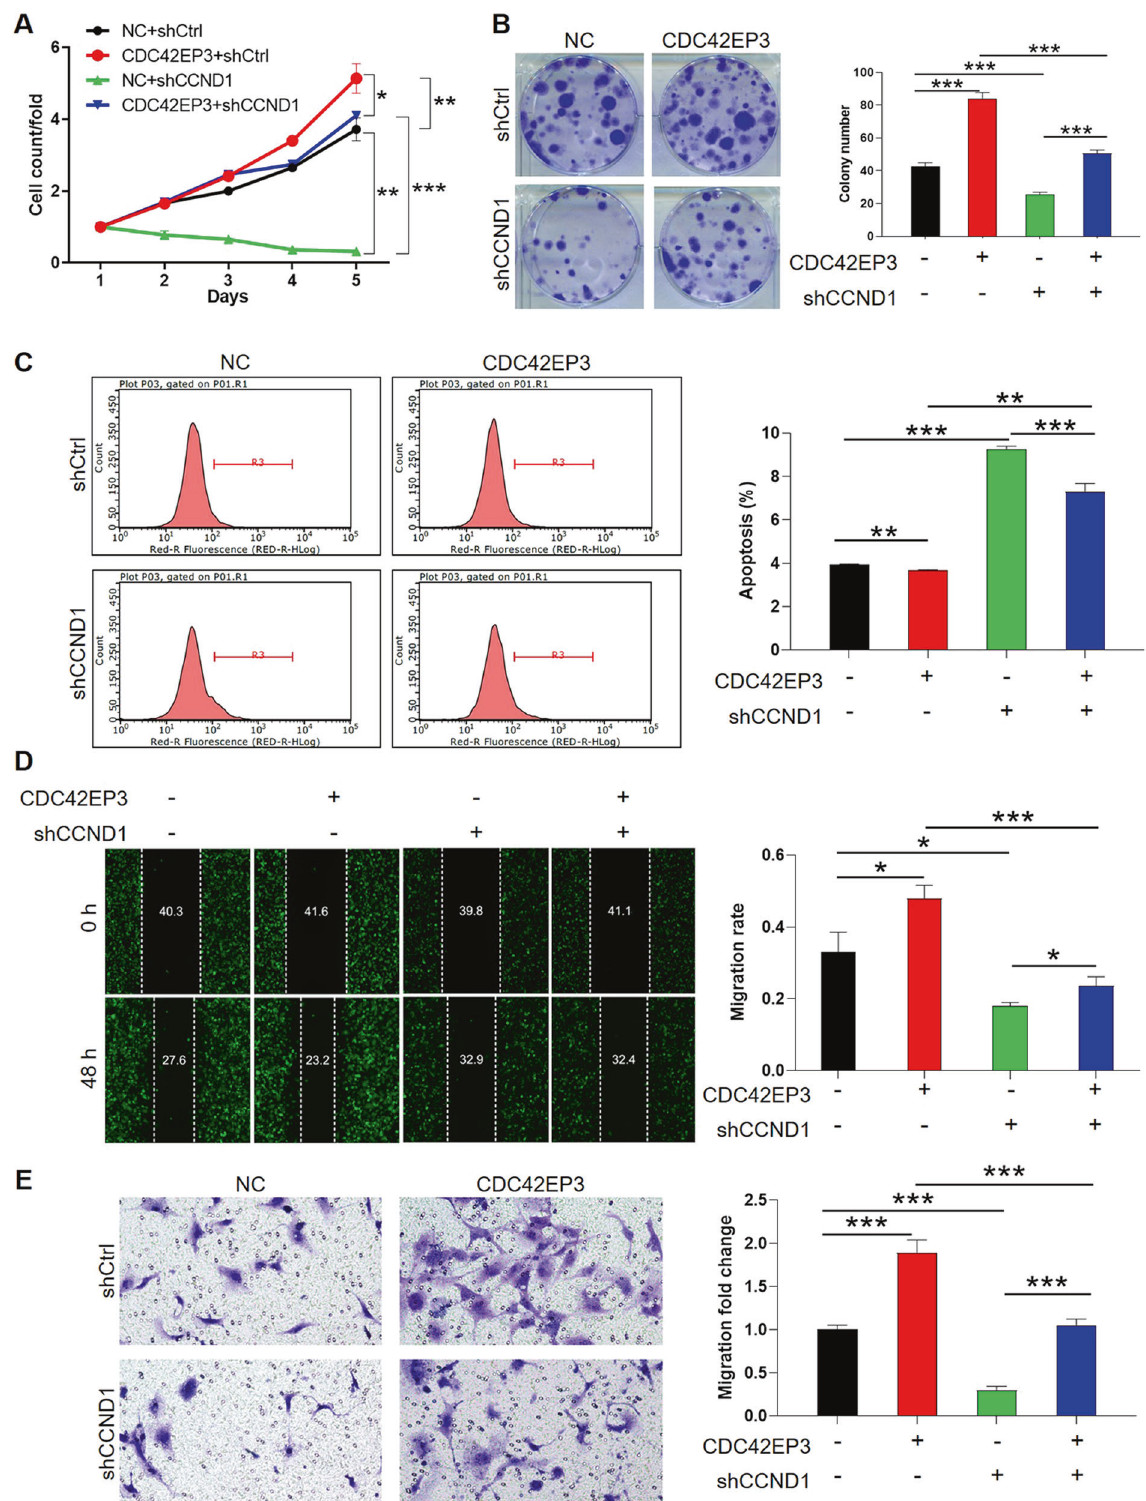
Fig. 6 CCND1 depletion mitigates pro-tumor effects induced by CDC42EP3 overexpression. CDC42EP3 overexpression (CDC42EP3 group), CCND1 knockdown (shCCND1 group) and CDC42EP3 overexpression + CCND1 knockdown (CDC42EP3 + shCCND1 group) cell models were constructed to carry out functional rescue experiments. A The comparison of cell proliferation between four cell groups resulted from Celigo cell counting assay. B Cell colony formation and the difference in colony numbers of four cell groups. C The comparison between percentage of apoptotic cells in four cell groups, derived from FACS. D Cellular ability of migration identi fi ed by wound-healing assay and the comparison of migration rate between different cell groups. E Representative images in Transwell assay and the differences in migration rate between four experimental cell groups. * P < 0.05, ** P < 0.01, *** P < 0.001.